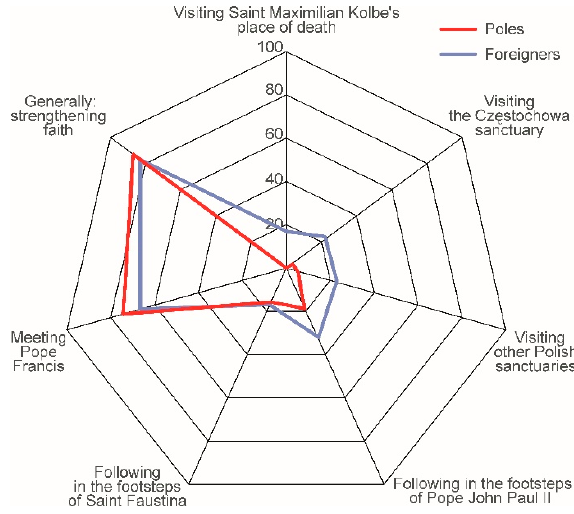
Figure 4. Religious purposes of respondents’ participation in World Youth Day. (Source: authors, based on a survey).